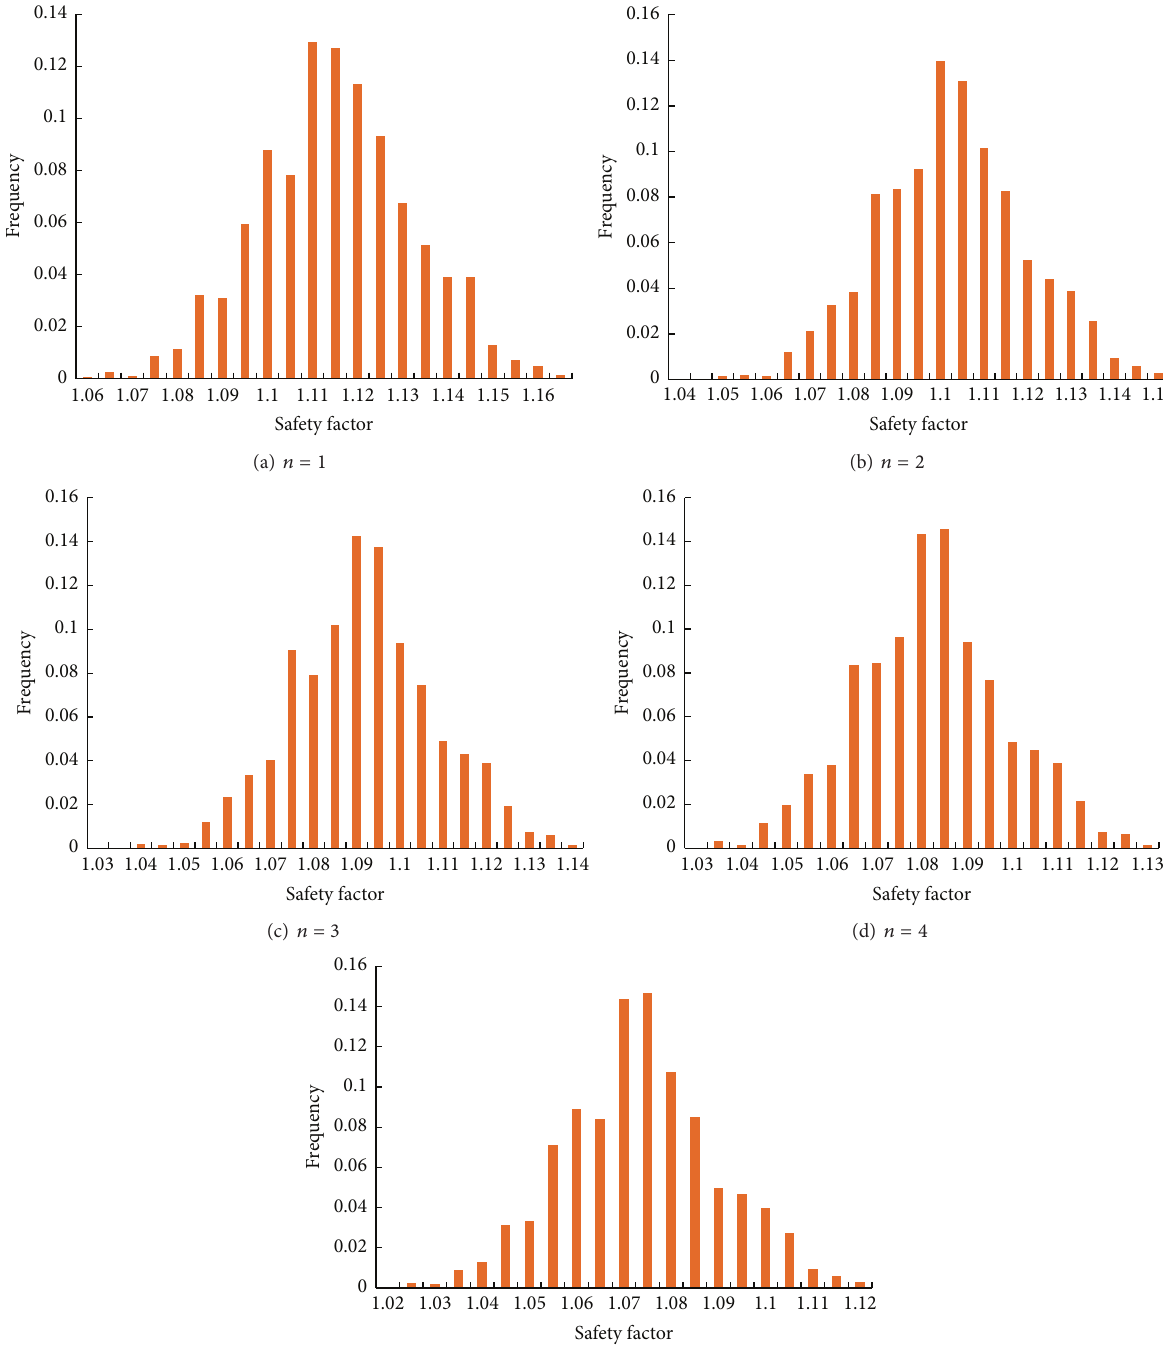
Figure 18: Distribution of safety